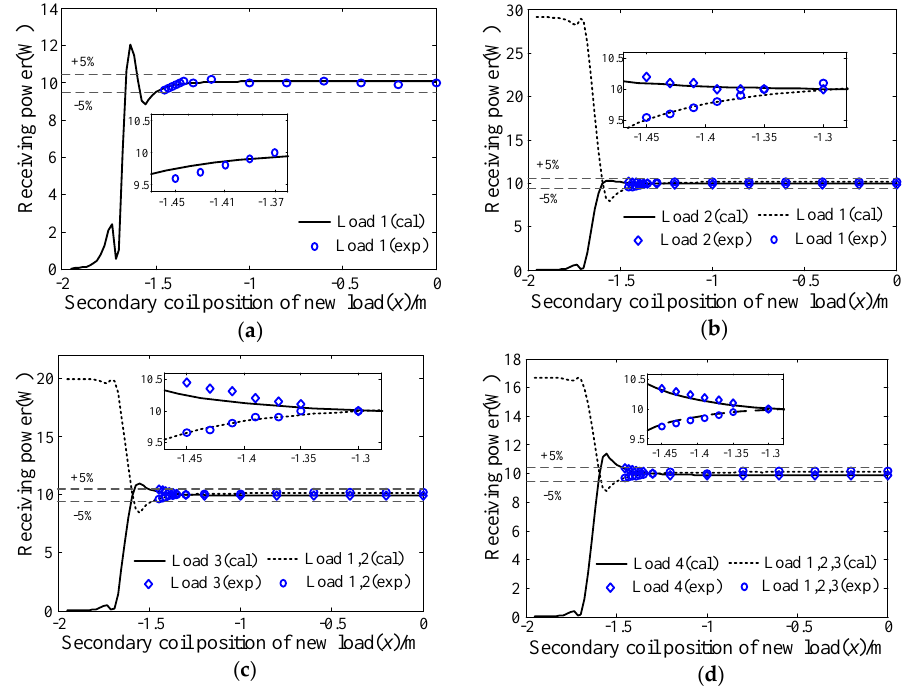
Figure 10. The experimental curves of received power versus position variation of the new access load: ( a ) one-load system; ( b ) two-load system; ( c ) three-load system; ( d ) four-load